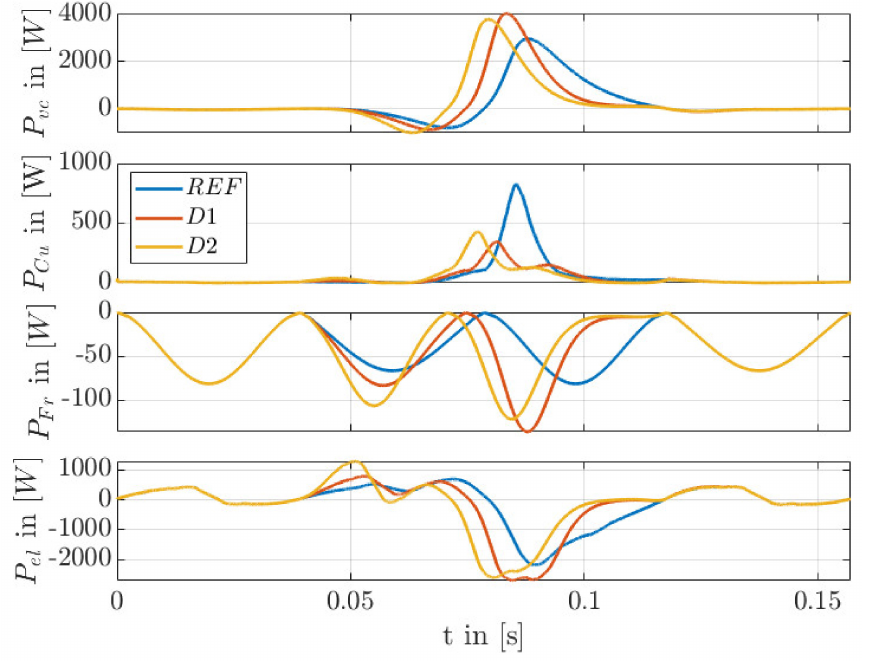
Figure 33. Comparison of trajectories REF, D1 and D2 related to the energy conversion of the electrical machine: volume change power, copper power losses, friction power losses and electric power depending on time.